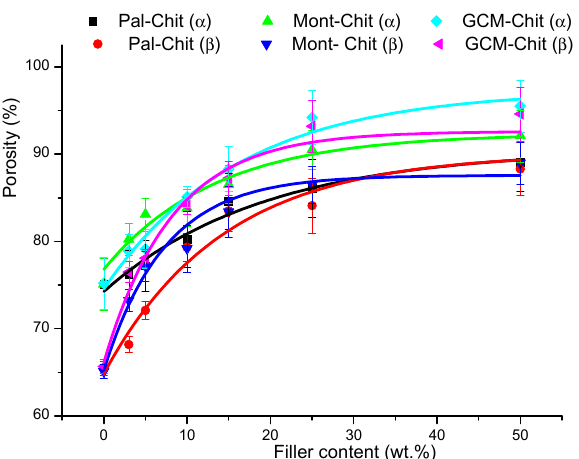
Figure 2. Changes in the porosity of the films studied versus the filler additions. Chit: chitosan; Pal: palygorskite; Mont: montmorillonite; GCM: geopolymer-containing material.